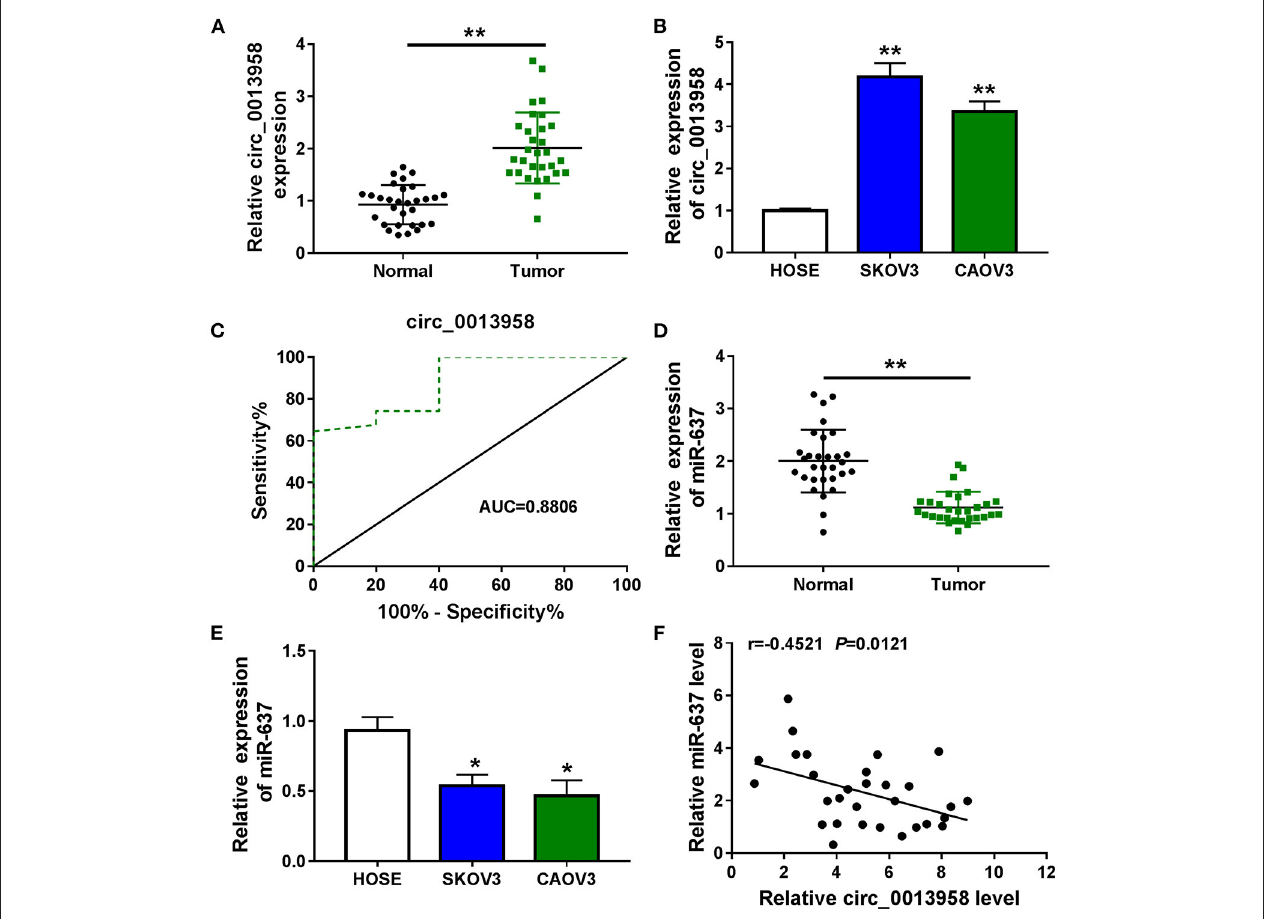
FIGURE 1 | Circ_0013958 was upregulated, while miR-637 was downregulated in OC tissues and cells. (A) QRT-PCR assay for the expression of circ_0013958 in OC tissues and adjacent normal tissues ( n = 30). (B) QRT-PCR analysis for the expression of circ_0013958 in OC cell line (SKOV3 and CAOV3) and human ovarian surface epithelial cells (HOSE). (C) ROC curve analysis of the prognostic sensitivity and specificity of circ_0013958 in OC patients in accordance with the 5-year survival of OC patients. (D) QRT-PCR assay for the expression of miR-637 in OC tissues and matched normal tissues ( n = 30). (E) QRT-PCR assay for the expression of miR-637 in HOSE, SKOV3, and CAOV3 cells. (F) Pearson’s correlation analysis for the correlation between the expression levels of circ_0013958 and miR-637 in OC tissues ( n = 30). * P < 0.05; ** P <